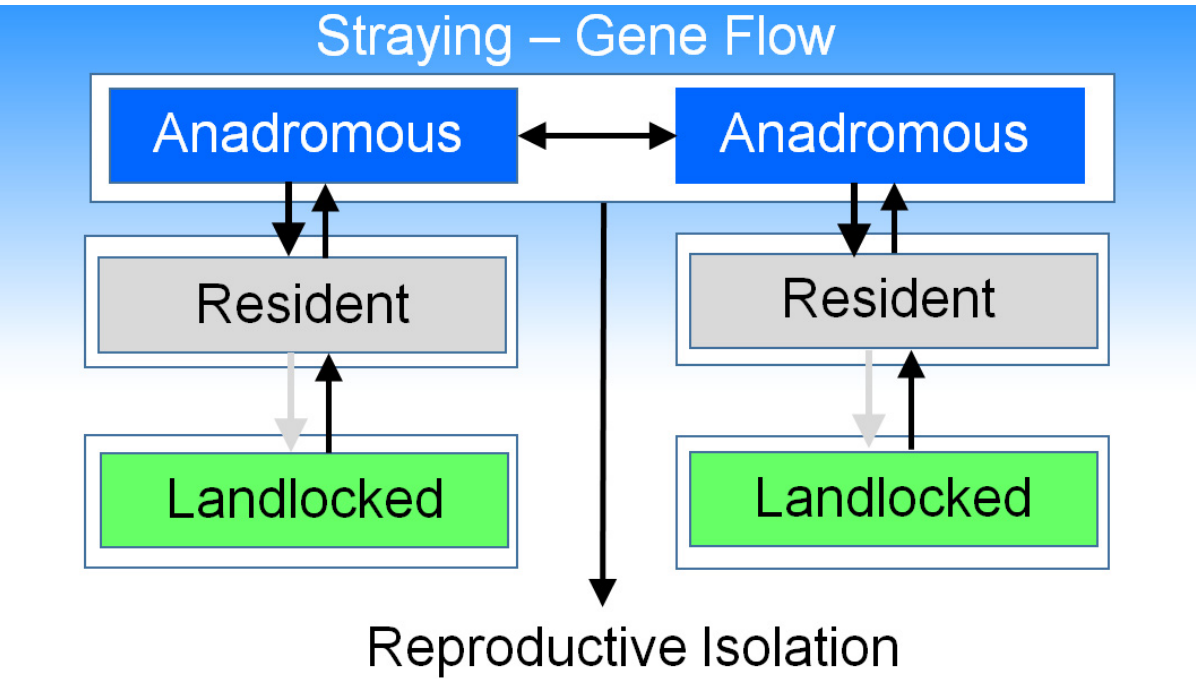
Figure 4. A model demonstrating the evolutionary processes comprising gene flow and/or repro- ductive isolation within two closely oriented gene pools of anadromous, resident, and eventually landlocked Arctic char. Table 2. Observed allele and genotype frequencies, their expected genotype distribution (in parenthe- ses), deviation from the Castle–Hardy–Weinberg proportions, and the 95% confidence interval at the EST-2* locus in anadromous (A), resident (R), and landlocked (L) Arctic char in Svalbard. Observed (Expected) Distribution Lake